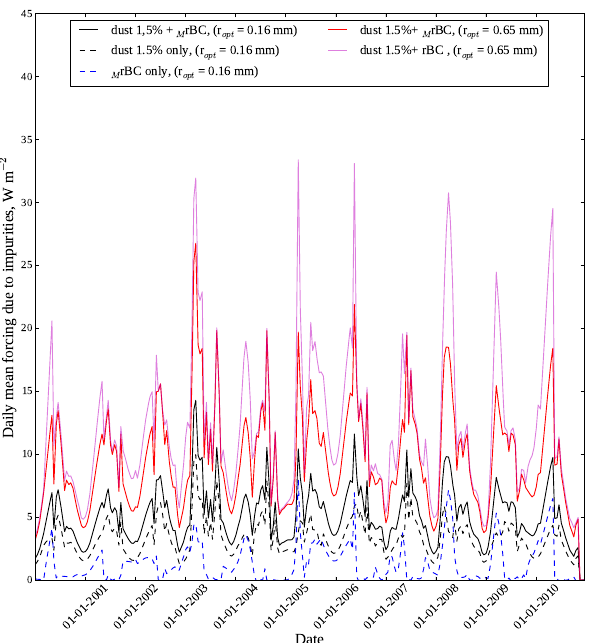
Figure 7. Daily mean radiative forcing of impurities in the clear sky simulation. The solid red and black lines represent the additional en- ergy due to the presence of dust and M rBC for coarse and fine snow. The black dotted line represents dust only and the blue dotted line represents M rBC only for fine grain snow. The pink line represents absolute rBC concentration, dust and for coarse grain. The hematite content of dust is 1.5% in all simulations.